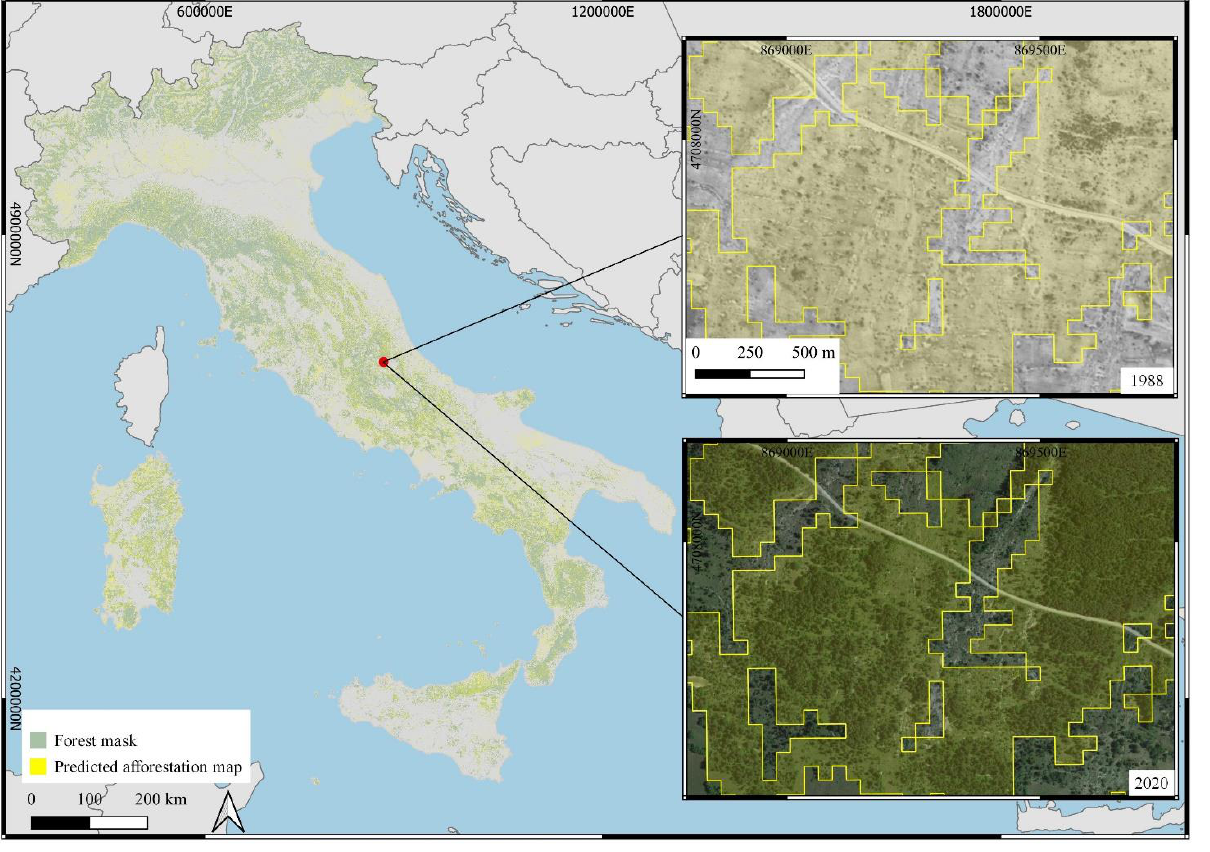
Figure 3. Afforestation map on the left and a highlighted portion and orthophoto on the right. The figures on the right show the area in 1988 and 2020. The afforestation can be seen in the areas mapped in yellow, while the other areas do not change. CRS, WGS84/UTM Zone 32N.